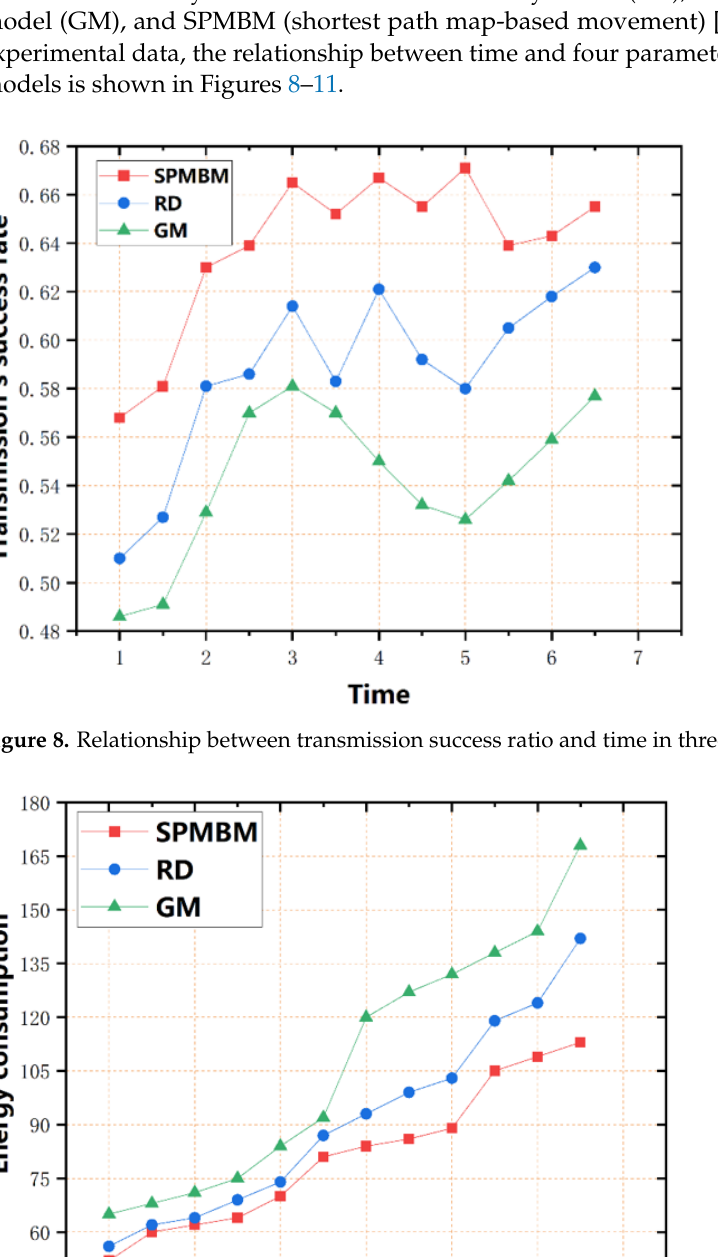
Figure 9. Relationship between energy consumption and time in three mobility models.